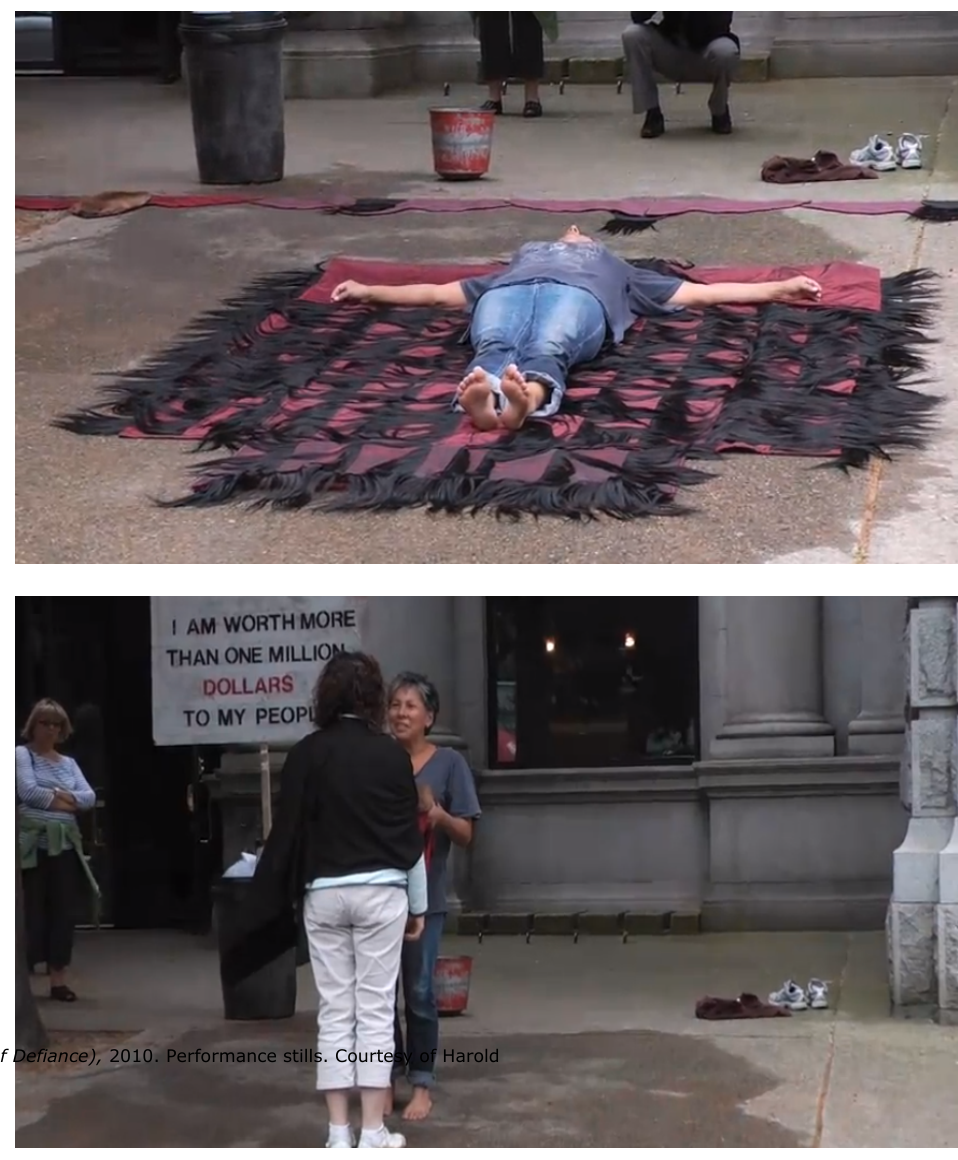
Rebecca Belmore, WORTH (A Statement of Defiance), 2010. Performance stills. Courtesy of Harold